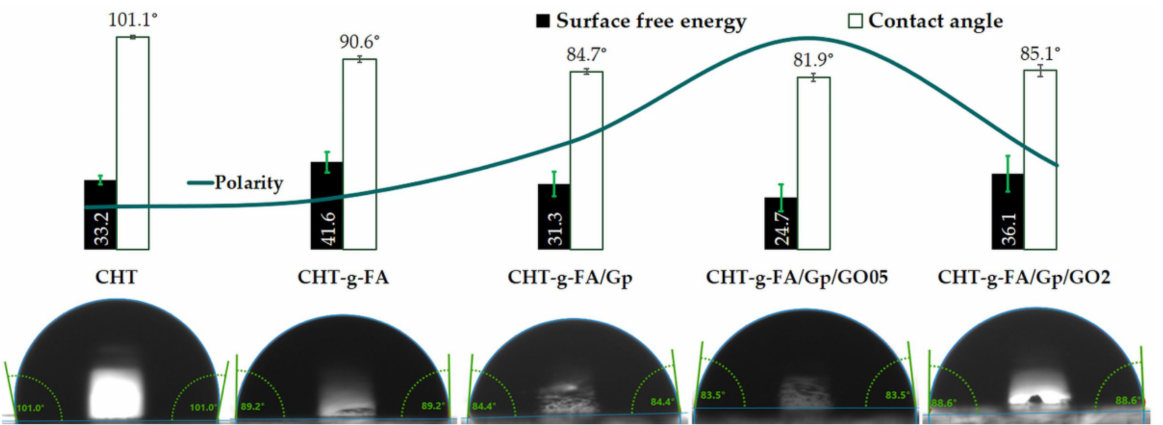
Figure 3. Material polarity, surface free energy and contact angle depictions according to sessile drop